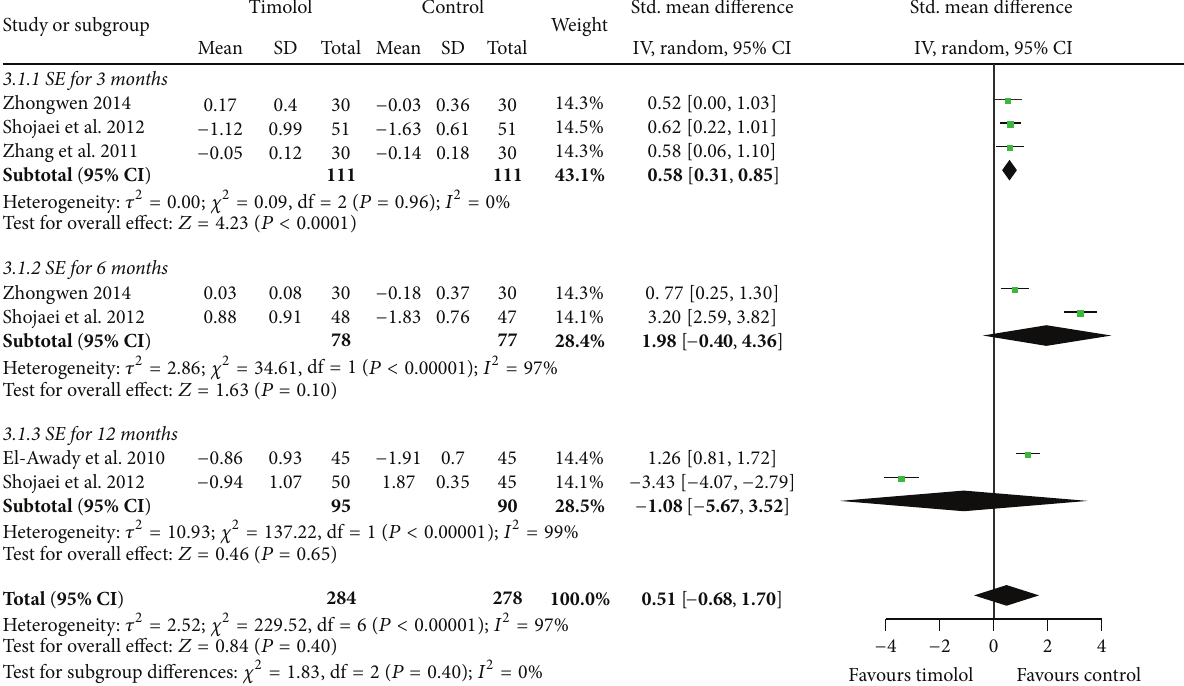
Figure3:Forestplotcomparingthesphericalequivalentrefractionintimololandcontrolgroups.SD:standarddeviation;IV:inversevariance; CI: confidence interval.